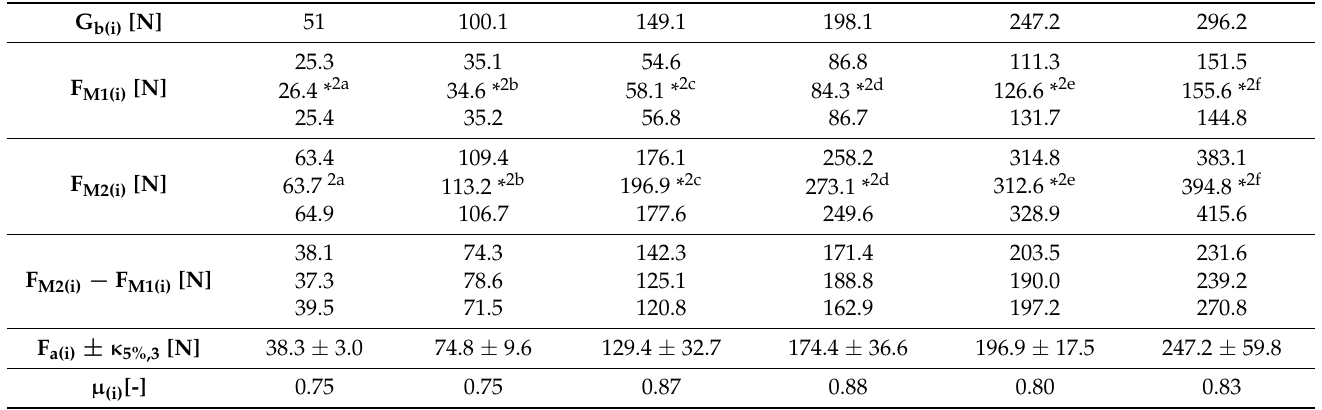
Table 3. Measured force F M1(i) [N] and F M2(i) [N] for the weight of the load G b(i) [N] at angle β = 10 deg.